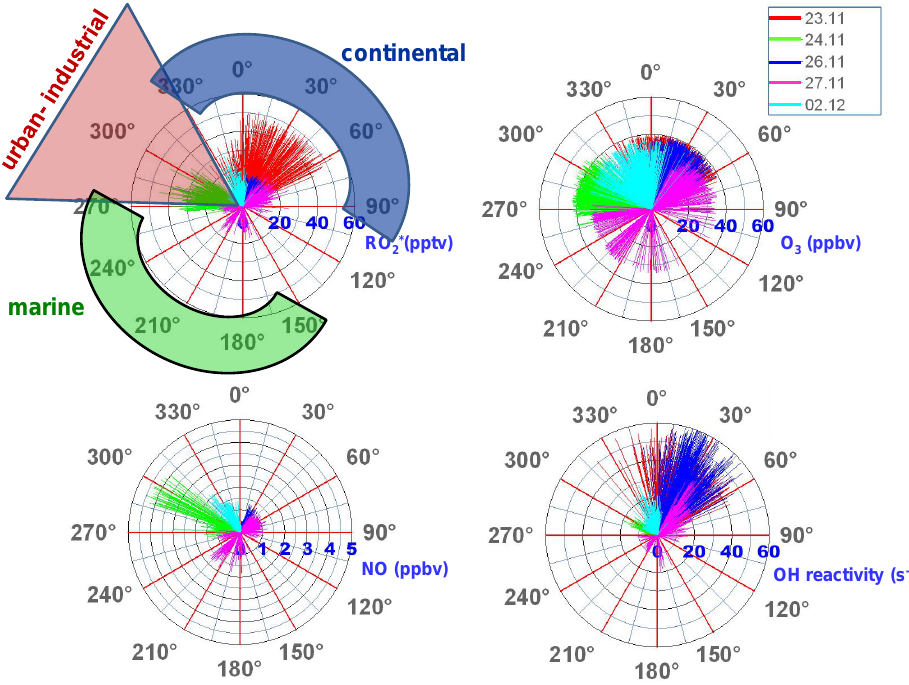
Fig. 8. Measured RO ∗ , O 3 , NO mixing ratios and OH reactivity versus wind direction under clear sky conditions. Only periods of photo- 2 chemical activity (06:00–17:00UTC) are considered. Wind sectors are indicated as additional information.